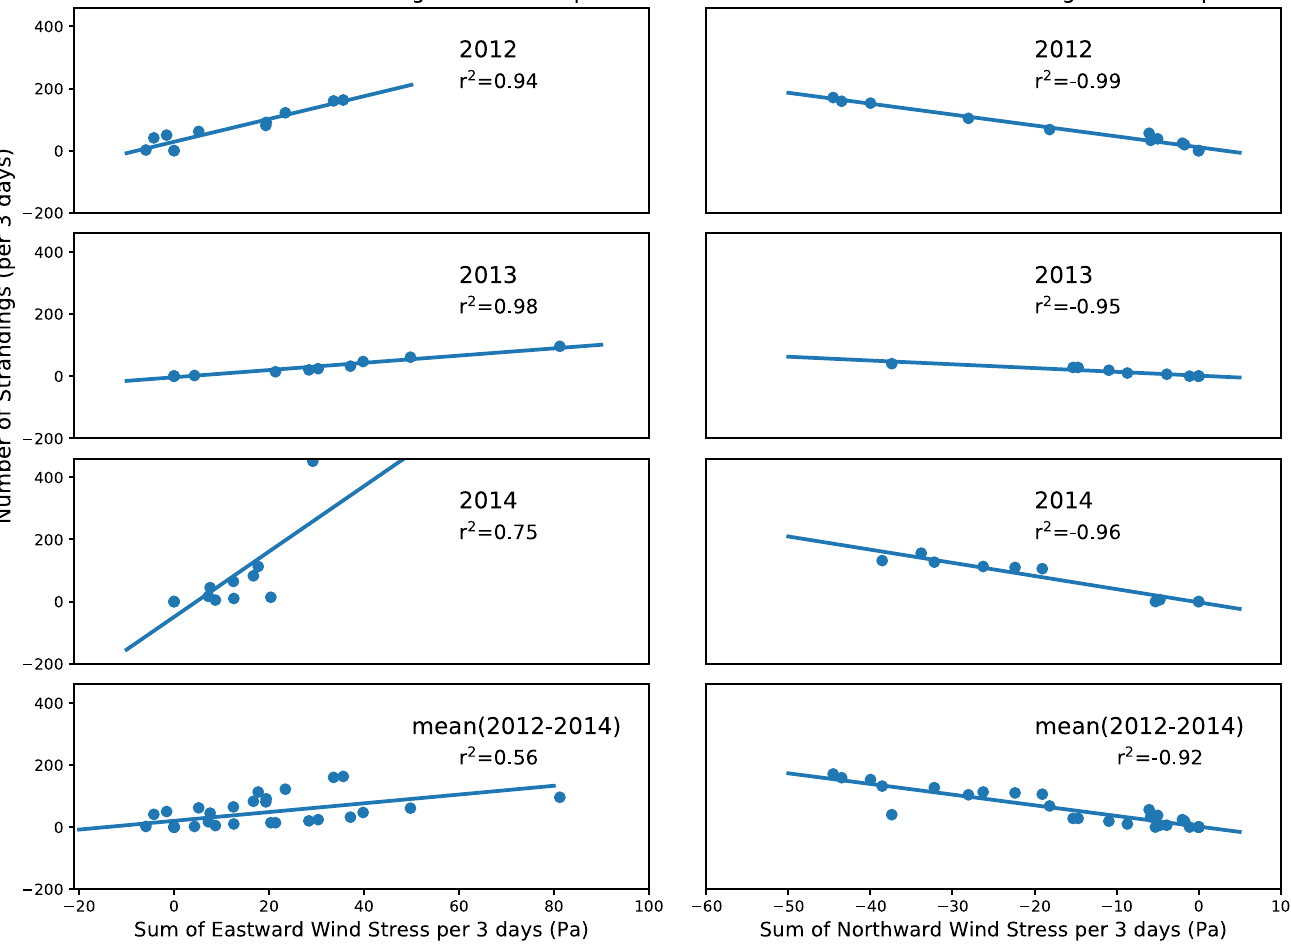
Fig 11. Linear correlations between eastward (left) and southward (right) components of the wind stress and number of strandings (summed over 3 days) in 2012, 2013, 2014 and mean (2012–2014) for Outer Cape (left) and Mid Cape (right) towns.